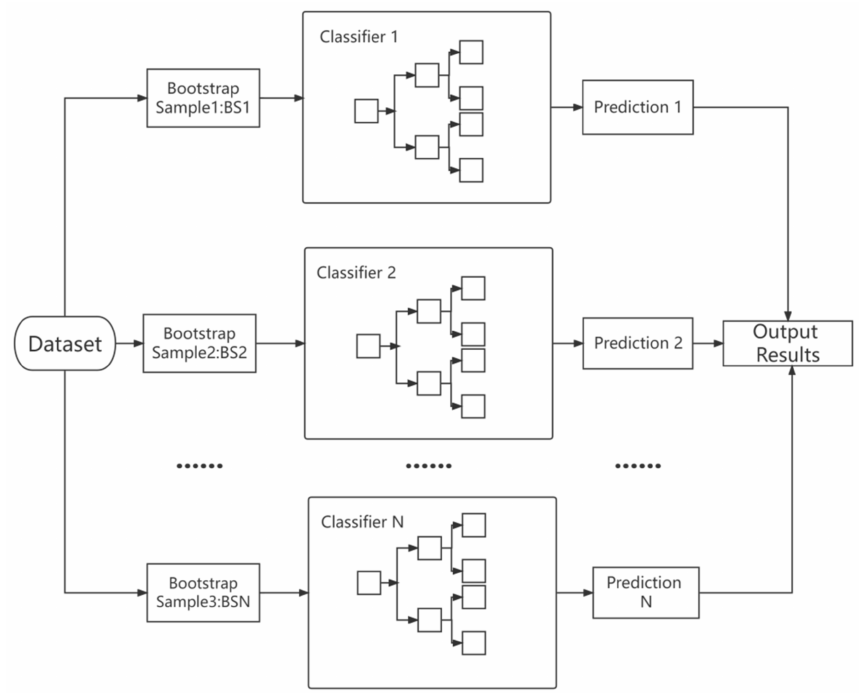
Figure 3. Random forest classification